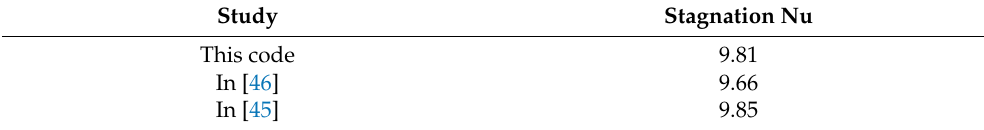
Figure 4. Code validation 2: comparison results of local Nu at Reynolds number of 250 with those in [44]. Table 1. Code validation 3: comparisons of stagnation point Nu at Reynolds number of